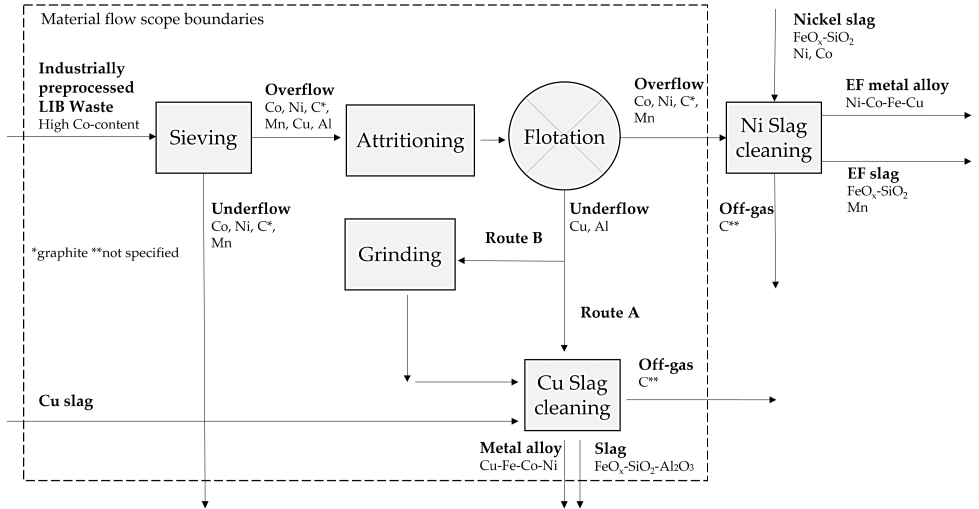
Figure 1. Flowchart of the combined waste LIB enrichment and refining processes investigated in the present and previous studies